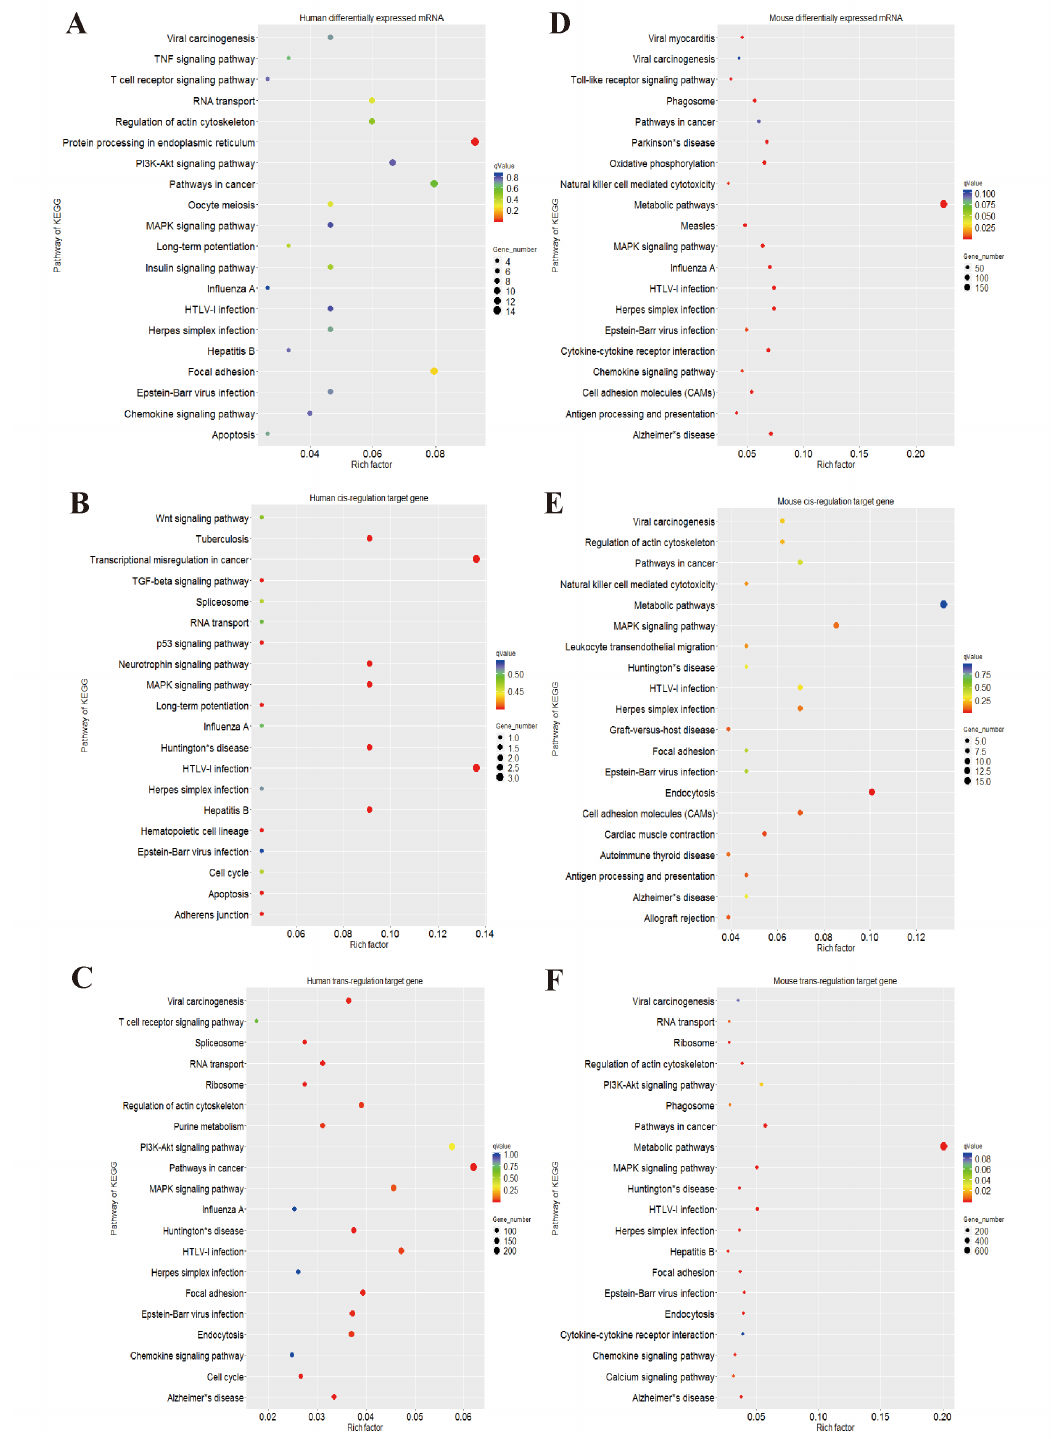
Figure 7. The Kyoto Encyclopedia of Genes and Genomes (KEGG) pathway analysis of differentially-expressed genes by EV71 infection. ( A – C ) The top 20 enriched pathways associated with differentially-expressed mRNAs, cis - and trans -acting target genes in EV71-infected RD cells, respectively. ( D – F ) The top 20 associated pathways in differentially-expressed mRNAs, cis - and trans - regulated mRNAs in EV71-infected skeletal muscle of mice,